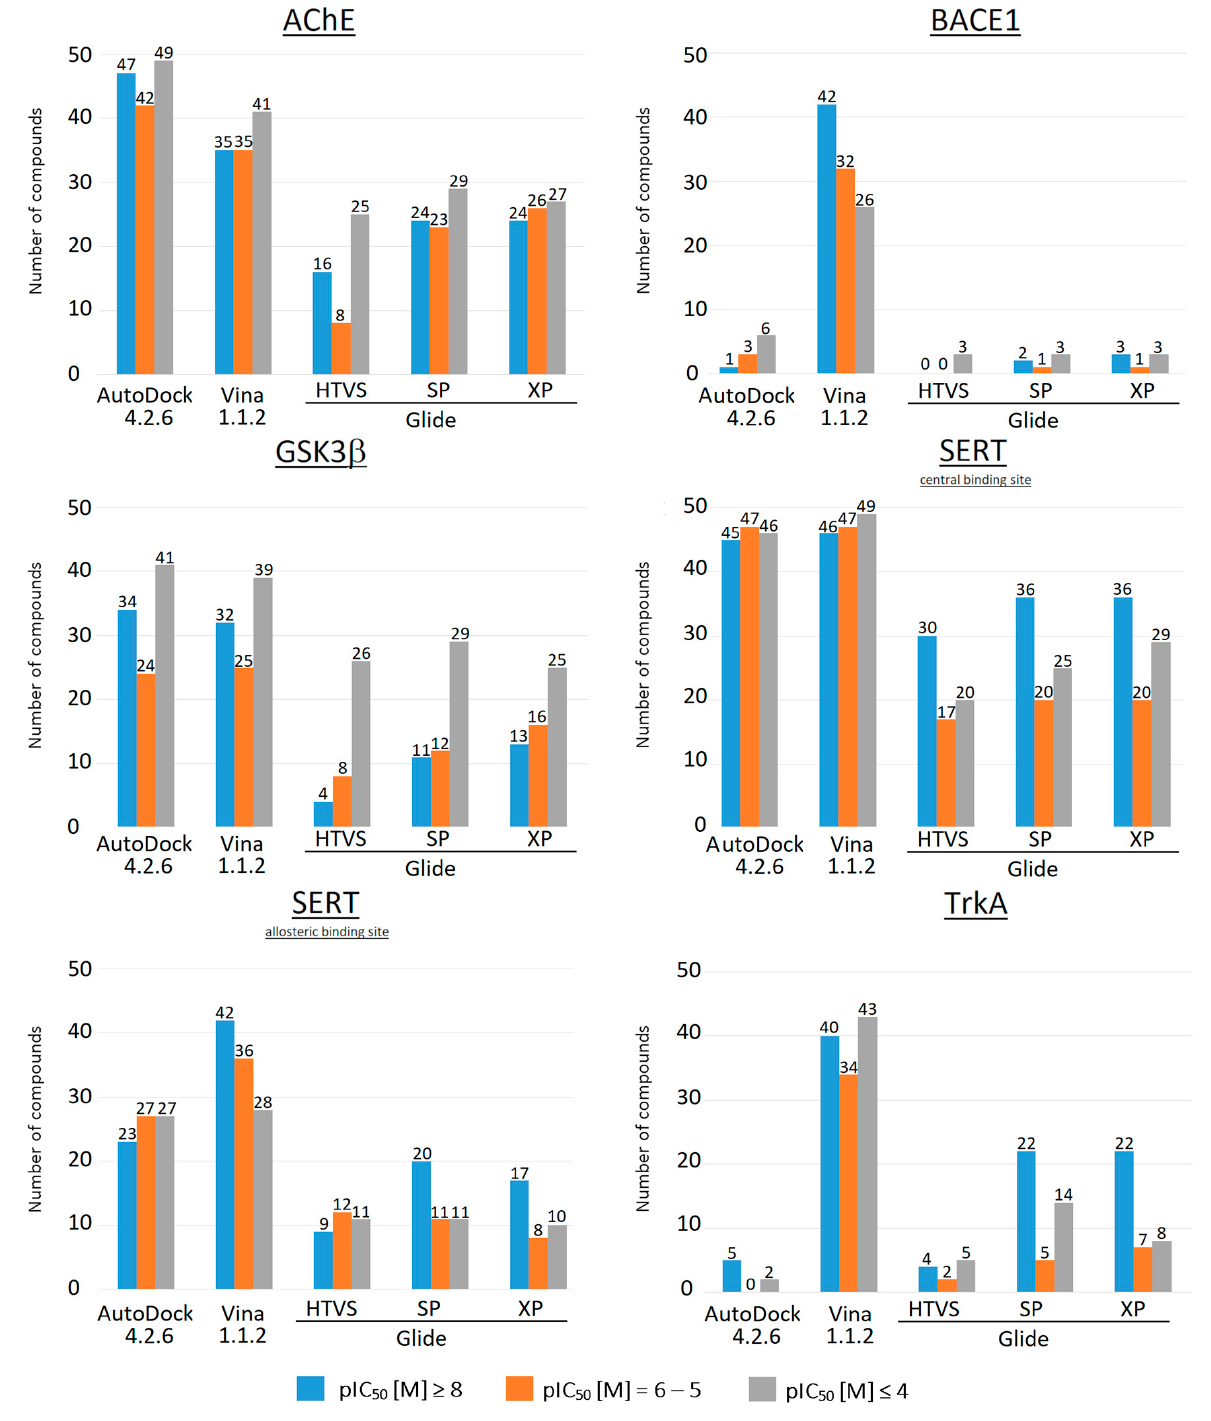
Figure 2. Number of compounds selected by calculated binding energy ( Δ G ≤ 8.0 kcal/mol) for all studied target proteins.